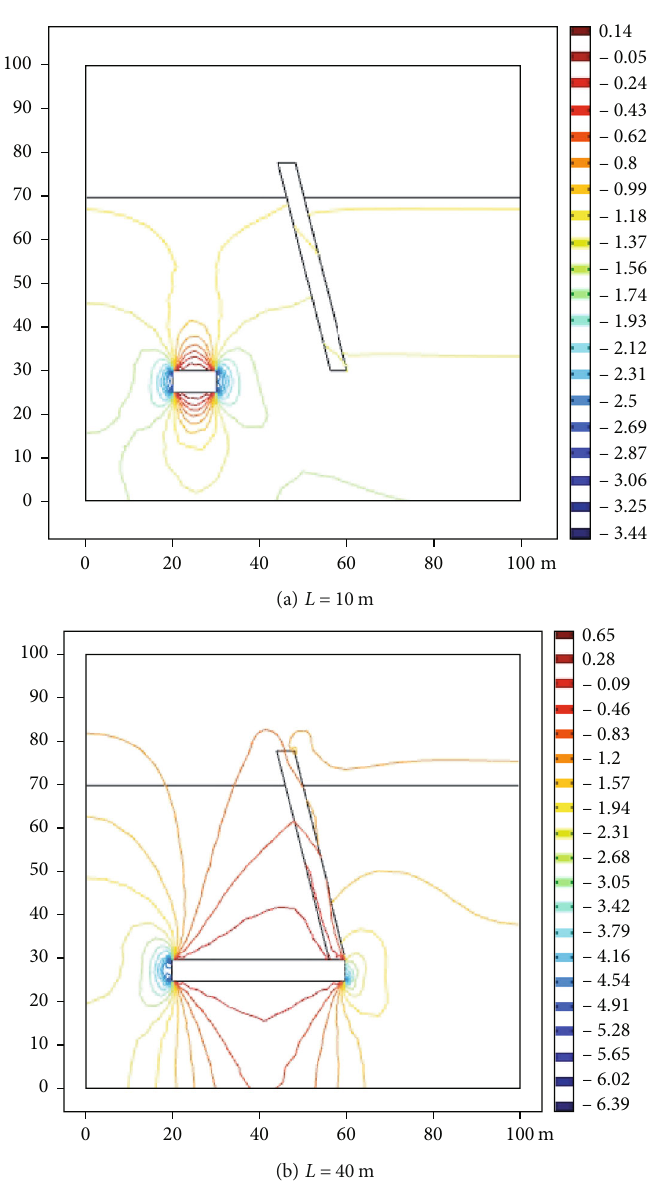
Figure 2: Contour lines of vertical stress ratio distribution on monitoring line